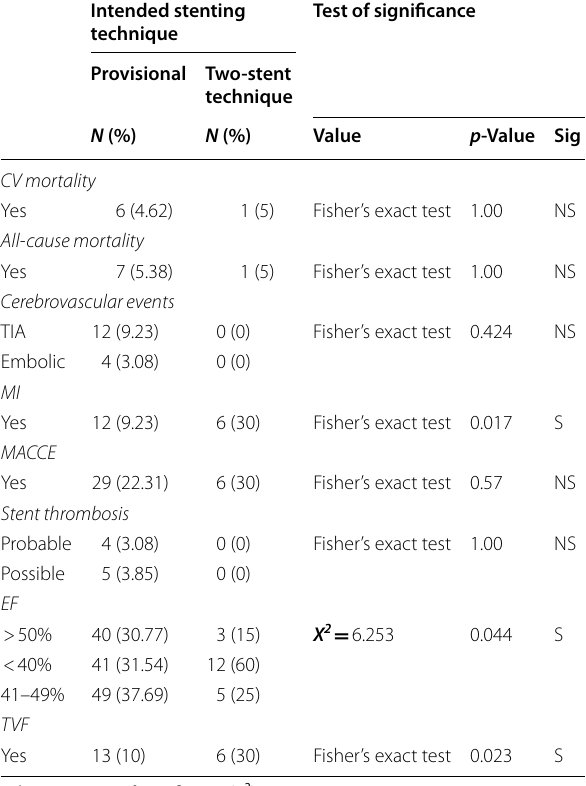
*Chi-square test of significance (X 2 )